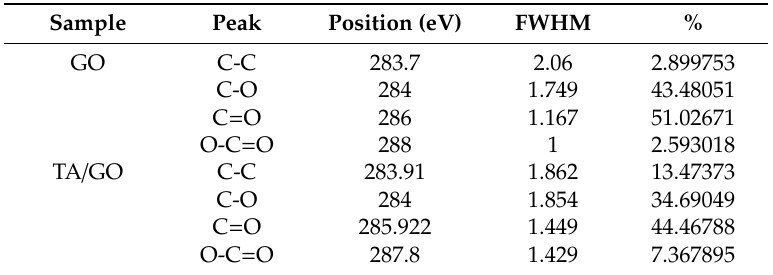
Table 1. Curve fitting results of XPS C1s spectra of GO and TA/GO composites.